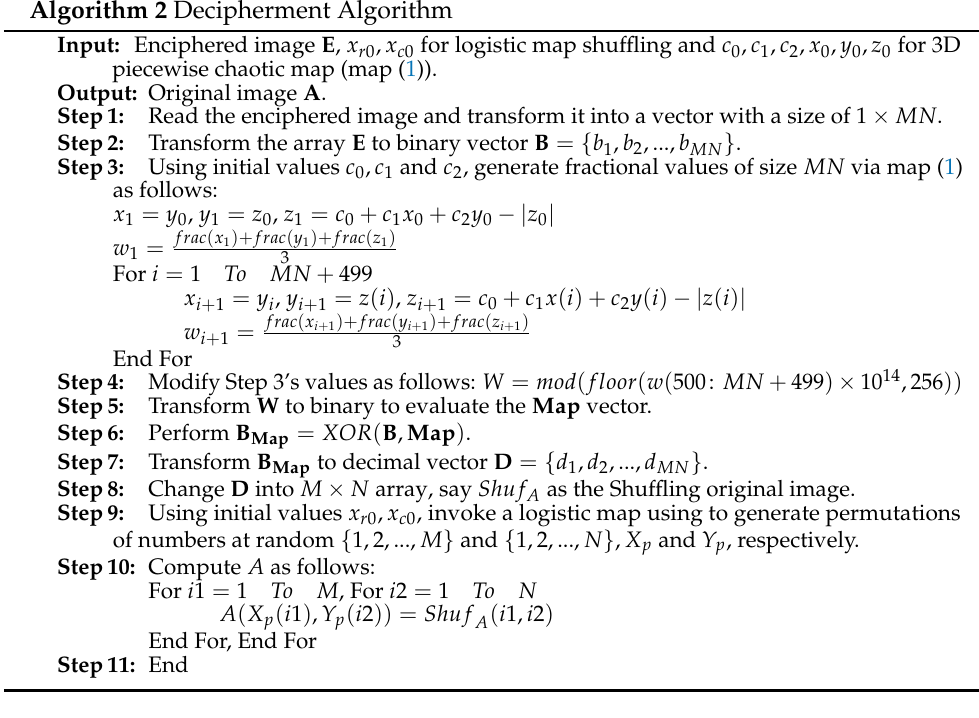
Algorithm 2 Decipherment